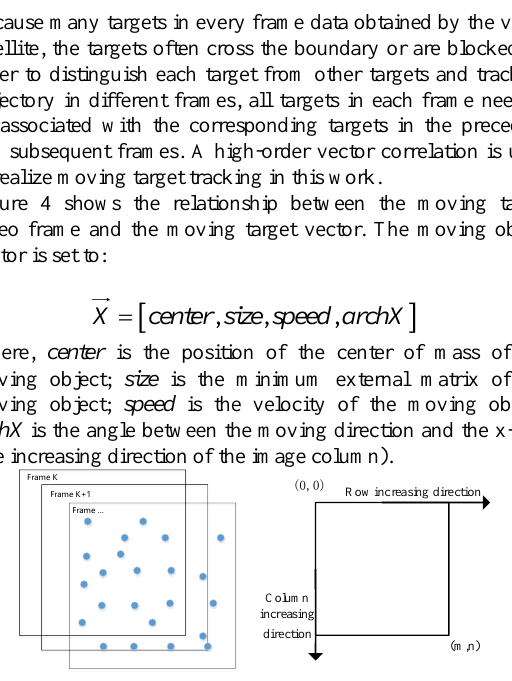
Figure. 4 Sketch map of video frame of moving object and moving object